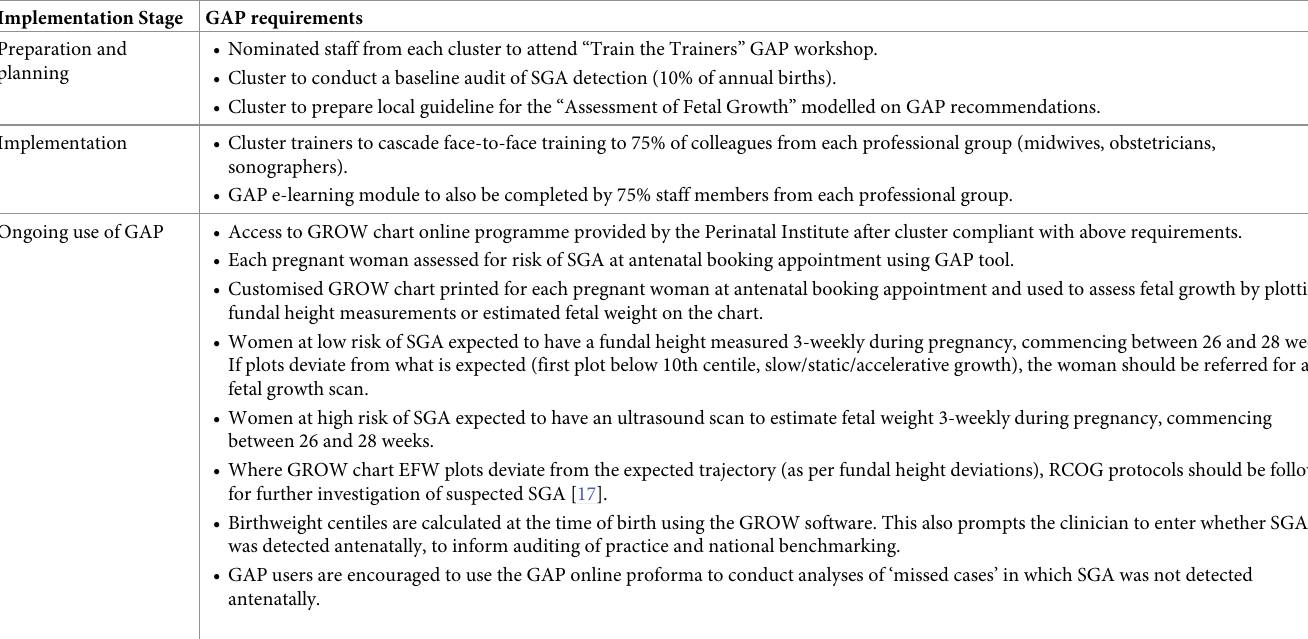
Table 1. Expected components of GAP